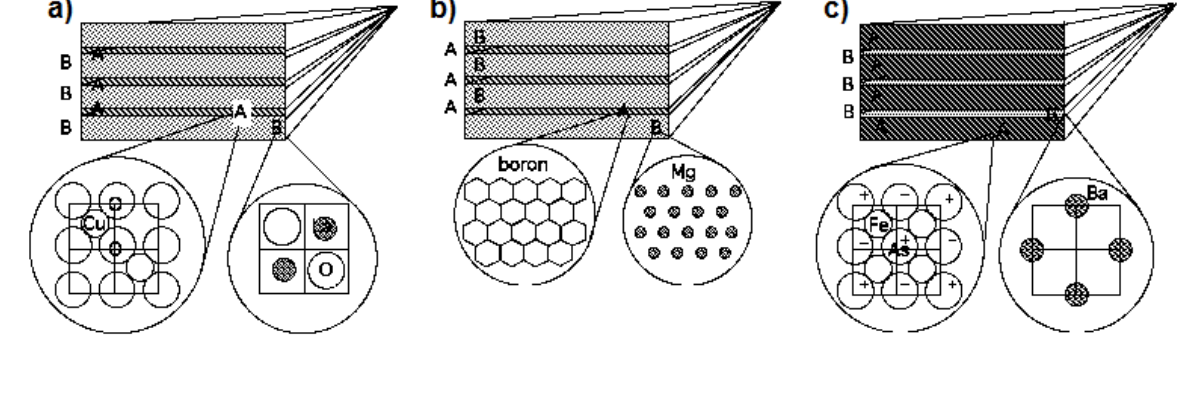
Figure 6 . Multilayered architectures formed by a superlattice of metallic superconducting units intercalated by a different material in three different high T superconductor families: a) cuprates, b) diborides, c)